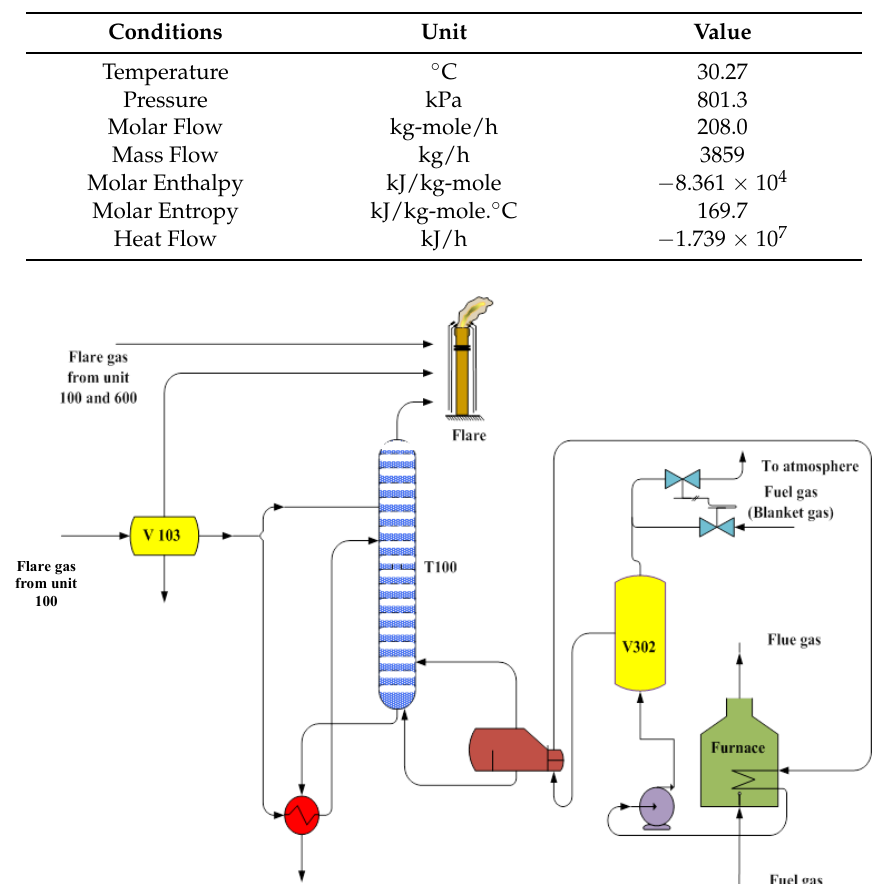
Figure 1. Process flow diagram of “Unit 300” of the domestic gas refinery.